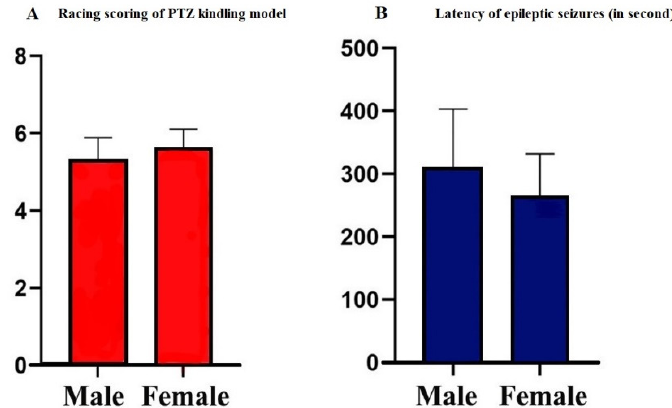
Figure 2. Racing score and seizure latency exhibited by male and female rats after each injection of pentylenetetrazol (PTZ). Values are presented as the mean ± SEM, n = 10 for each group. At the 13 th injection, generalized tonic–clonic seizures, corresponding to phase 5 of the Racine’s scaling system score, were observed in both male and female rats (5.31 ± 0.58 and 5.2 ± 0.47) ( A ). PTZ-kindled female rats had their first seizure in 266 ± 66 s while PTZ-kindled male rats had their first seizure in 308 ± 95 s ( B ).